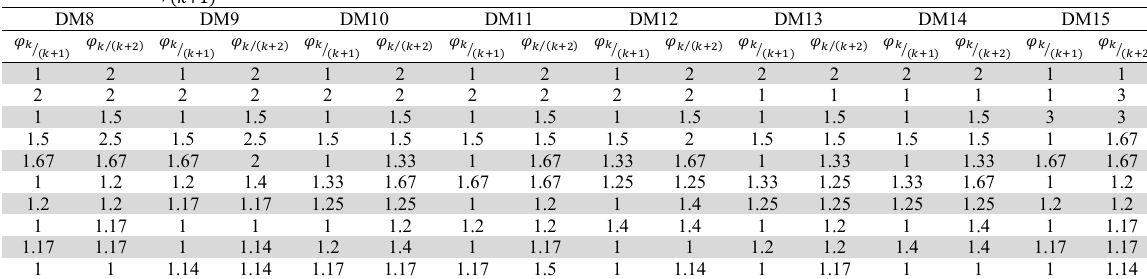
The results of 𝜑 (cid:3038)